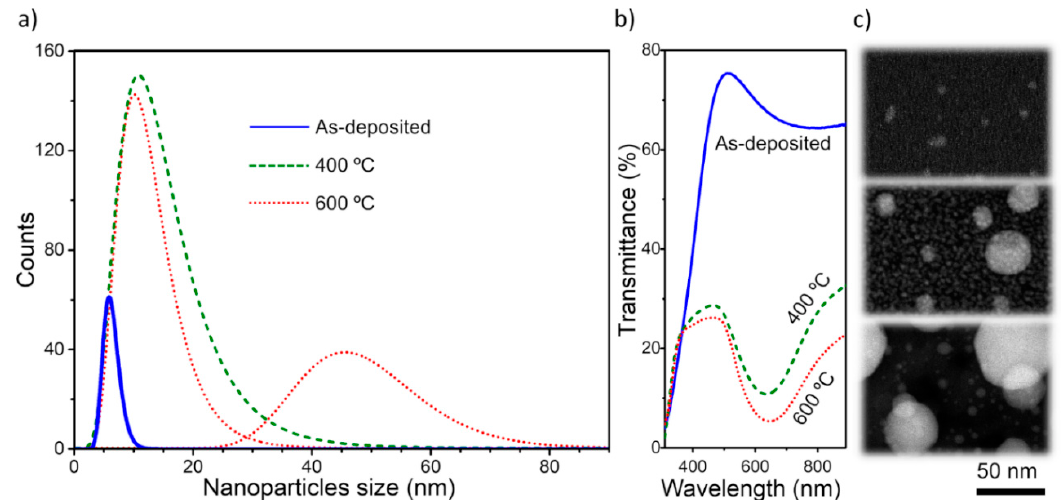
Figure 3. ( a ) Size distribution of Au nanoparticles embedded in a TiO 2 matrix for different annealing temperature conditions, ( b ) corresponding transmittance spectra, and ( c ) transmission electron microscopy images of the thin films.